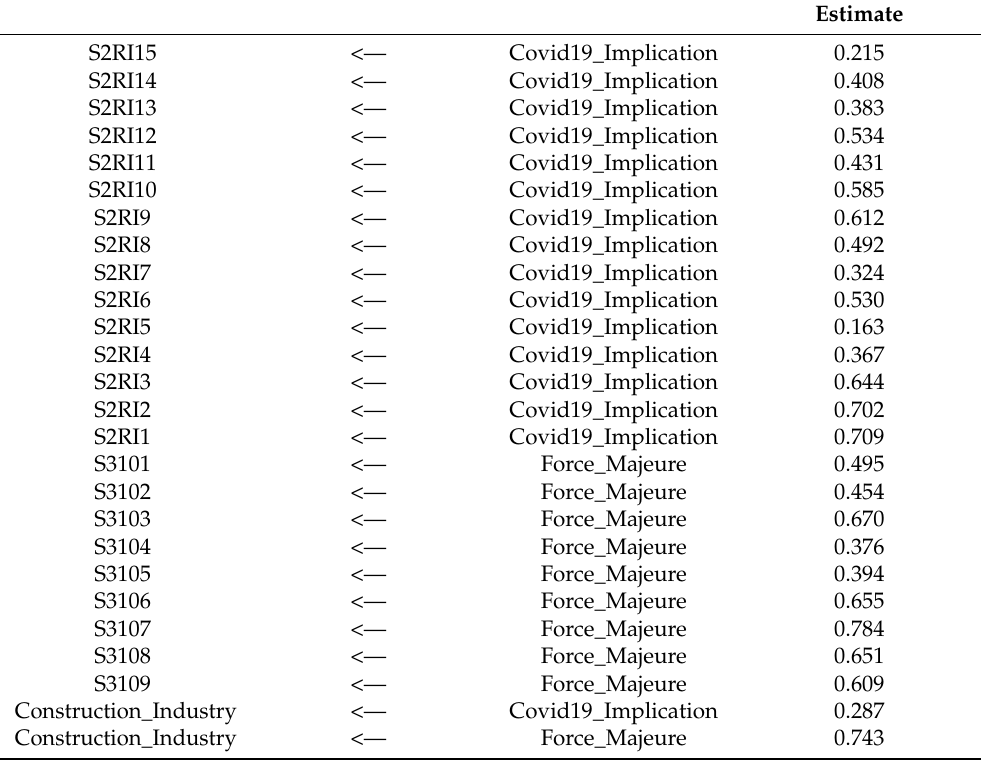
Table A1. Showing standardized regression weights in the modified model.